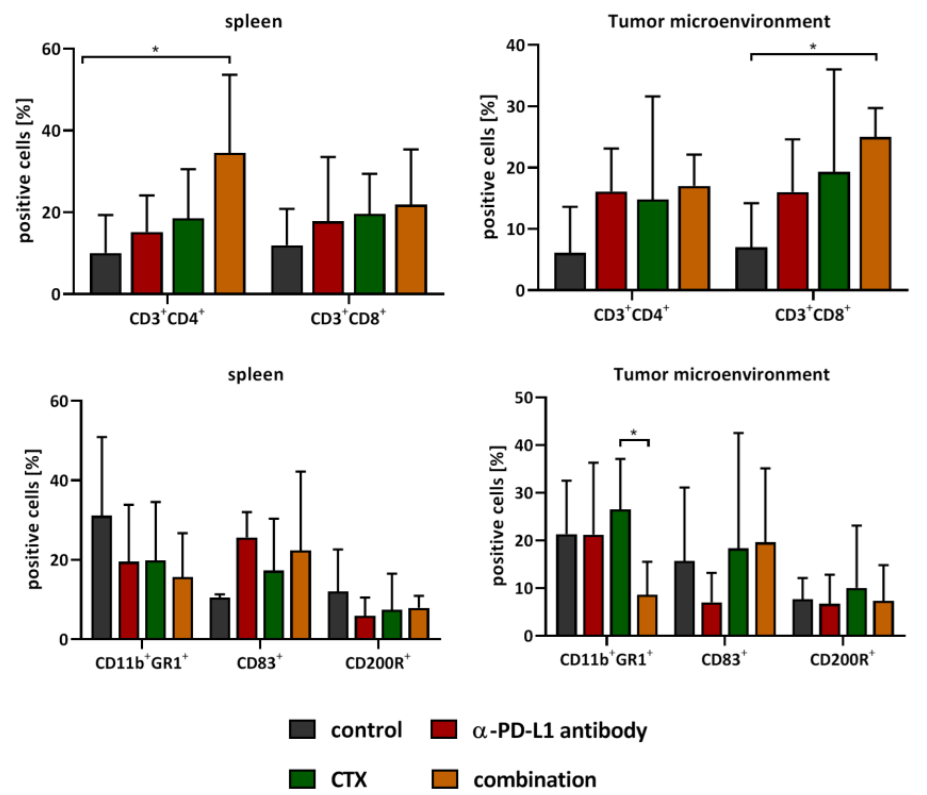
Figure 4. Flow cytometric phenotyping of spleens and tumor microenvironment. At the endpoint, spleen and tumor were resected. The single cell suspension was stained with respective antibodies and screened for immunological markers via flow cytometry. Represented are the numbers of positive cells ± SD resulting from 20,000 events, n = 3–5 mice/group. * p < 0.05 one-way ANOVA (Bonferroni’s multiple comparison test).